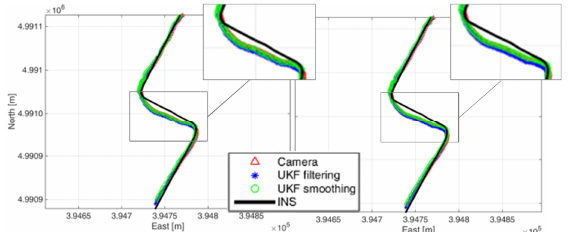
Figure 11. On the left: UKF augmented trajectory with 6 states; on the right: UKF not-augmented trajectories with 6 states